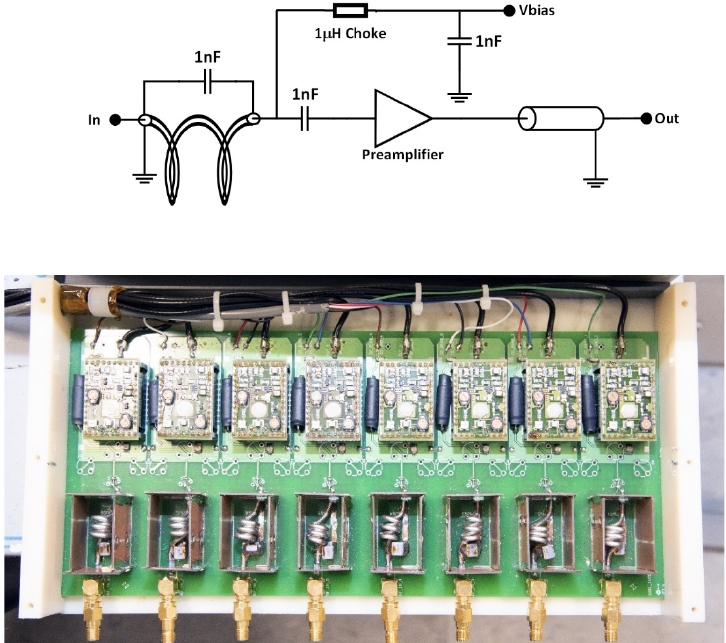
Figure 3. ( Top ) Schematics of the eight-channel pre-amplifier interface board. ( Bottom ) Images of the pre-amp board populated with components and connections.